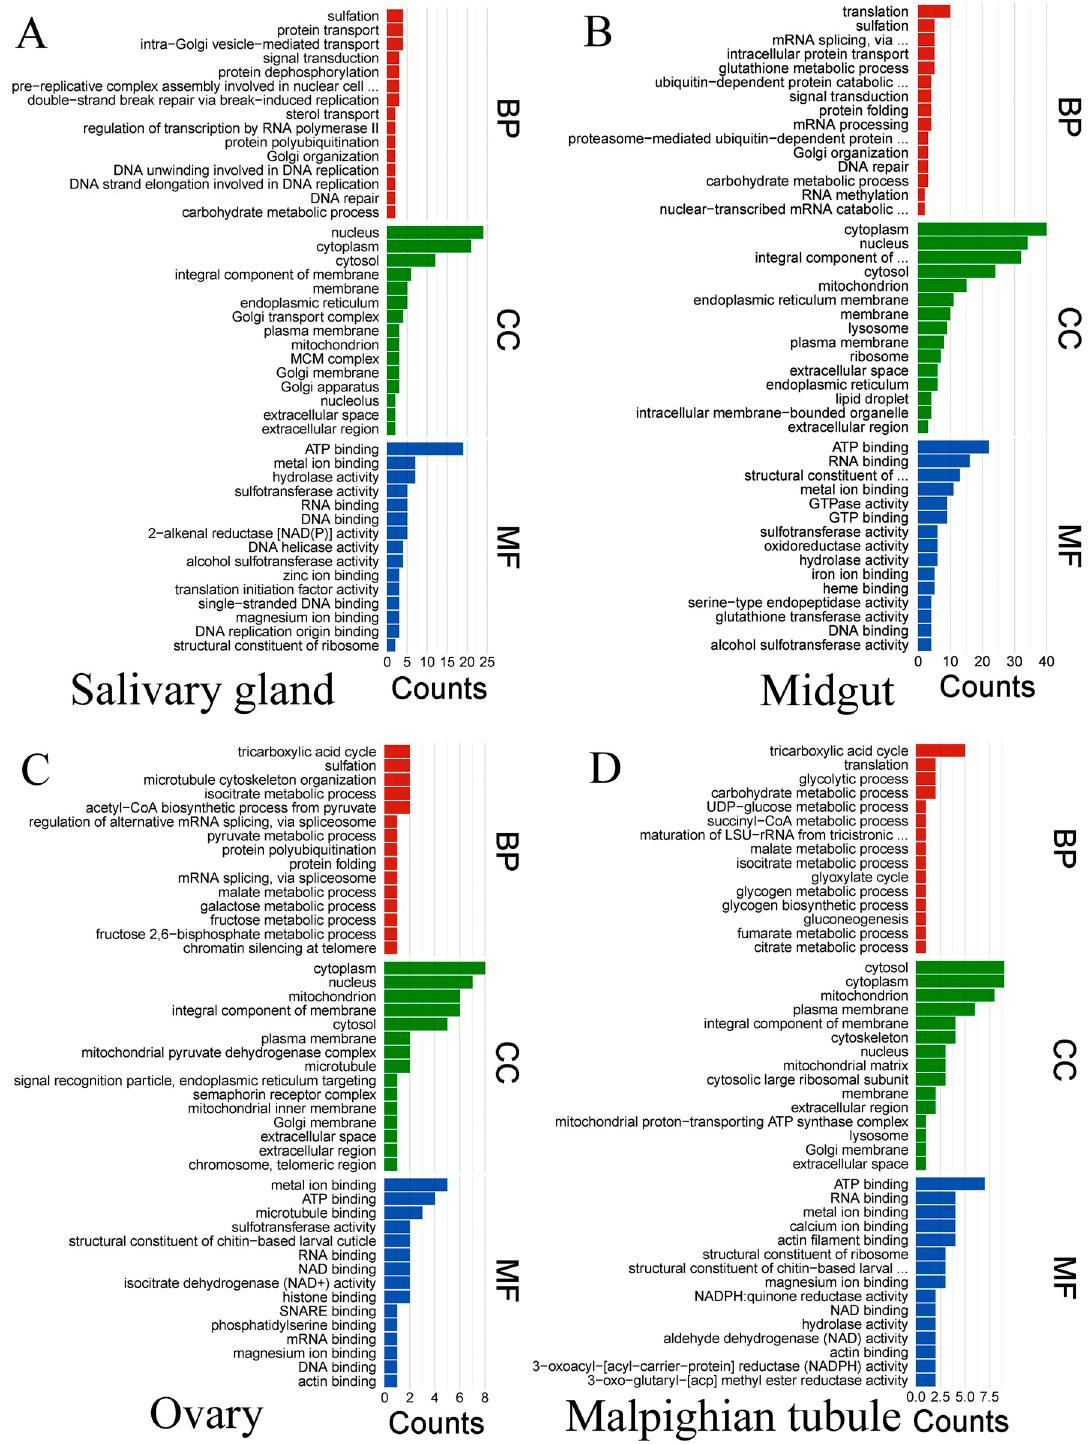
Fig 5. Gene ontology (GO) enrichment analysis of differentially expressed proteins in four tissues of female H . longicornis at different stages of starvation. BP: Biological process; CC: Cellular component; MF: Molecular function. A. Salivary glands, B. Midguts, C. Ovaries, D. Malpighian